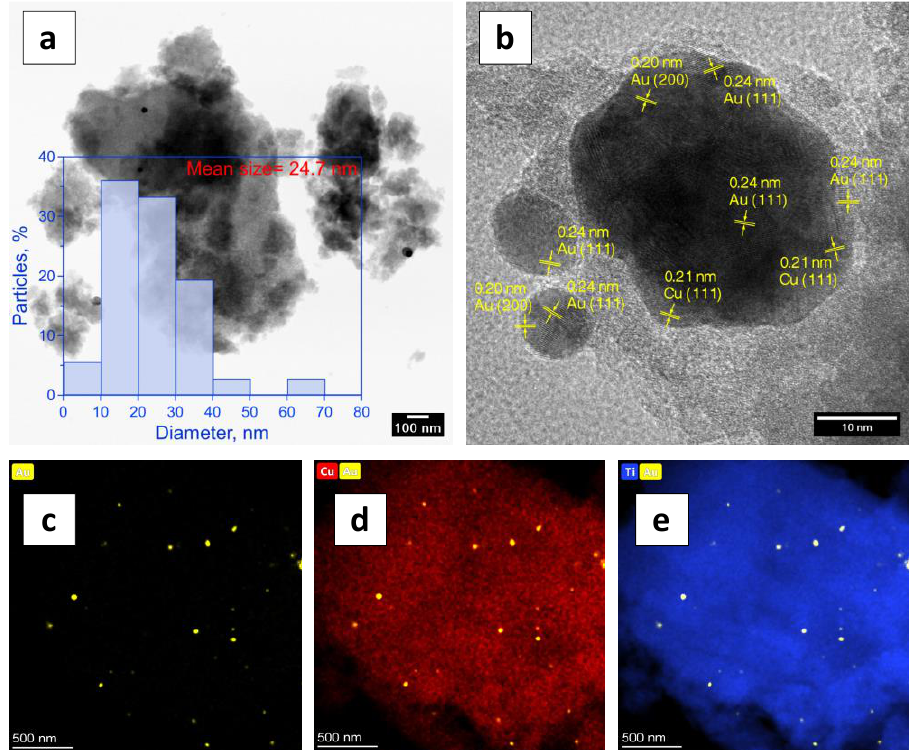
Figure 5. TEM images of the obtained CuN-Au/TiO 2 sample: SE mode with particle size distribution ( a ), SE mode ( b ), EDS HAADF analysis of Au ( c ), EDS HAADF analysis of Cu and Au ( d ), and EDS HAADF analysis of Ti and Au ( e ).